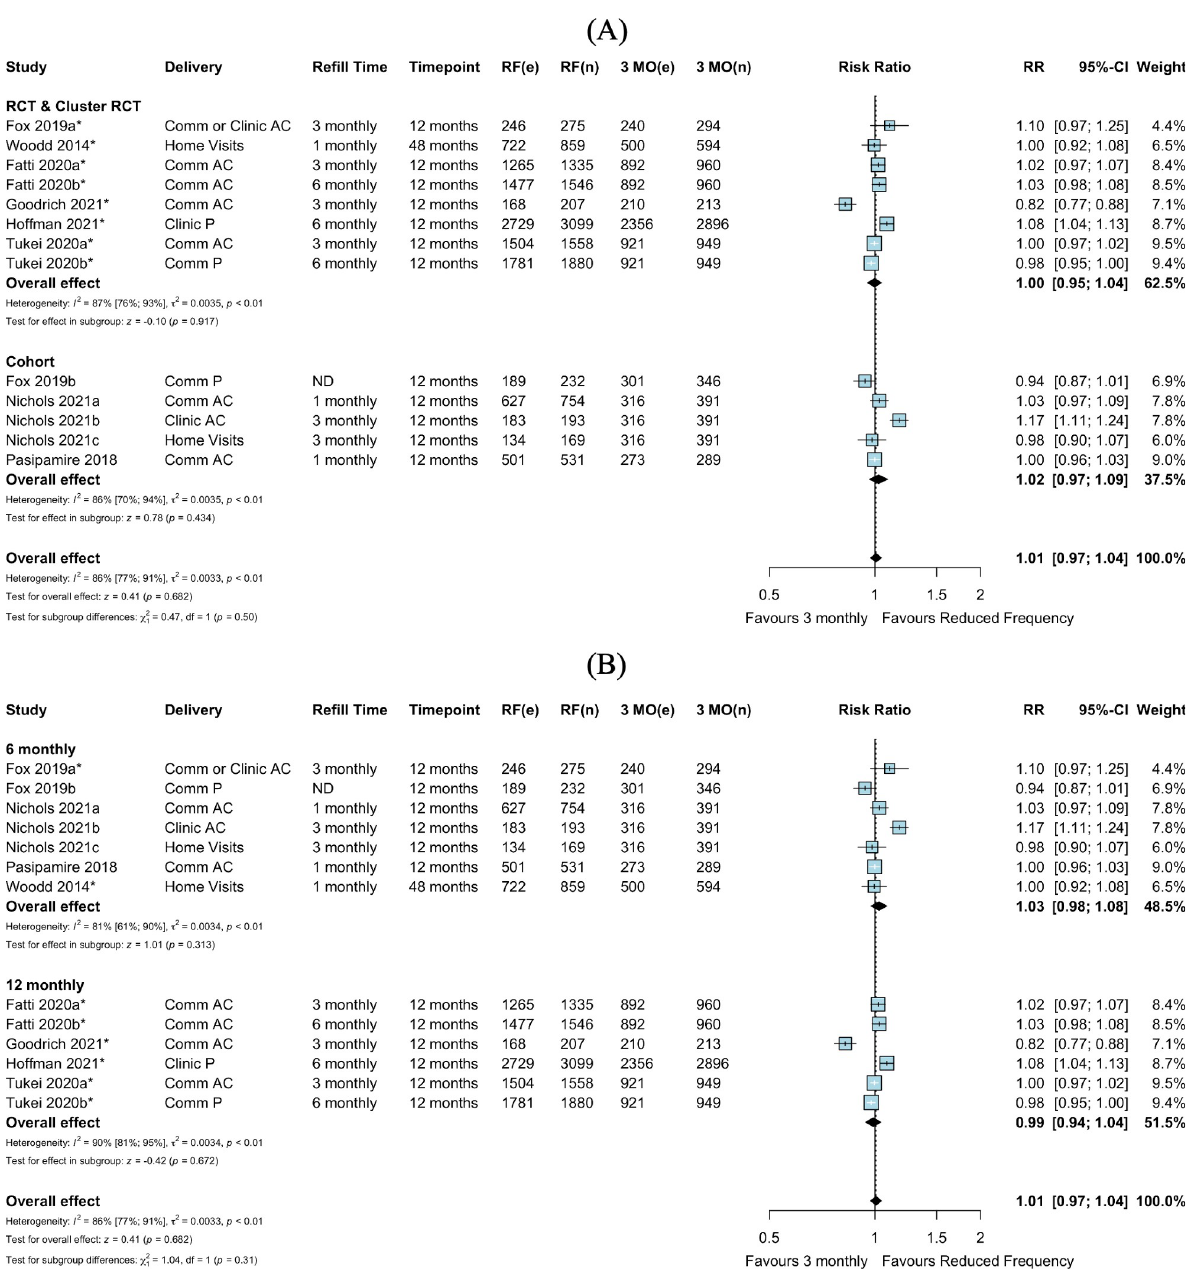
Fig 2. Retention in care: Reduced frequency versus 3-monthly clinical consultations among randomized or enrolled individuals. (A) By study design. (B) By clinical consultation frequency. Goodrich 2021 had high withdrawal from the intervention (community-based care) arm; it was unclear if those who withdrew reengaged in care at the health facility. Fox 2019a and Fox 2019b were separated into an RCT and cohort design, respectively, based on the analysis described by the authors, where randomization was not preserved in the intervention arm in Fox 2019b. � Cluster- adjusted RR. 3 MO, 3-monthly; AC, adherence club; Comm, community; e, number of events; n, number of participants; ND, not described; P, pharmacy; RCT, randomized controlled trial; RF, reduced frequency; RR, risk